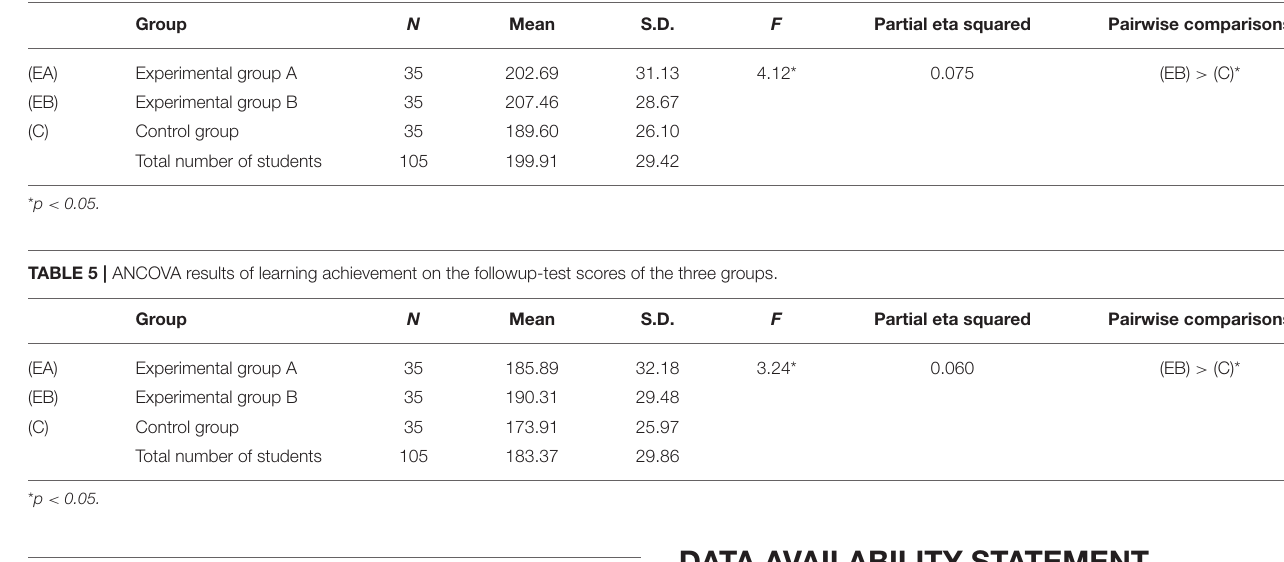
TABLE 6 | ANOVA result of cognitive load on the three groups. Group N Mean (EA) Experimental group A Experimental group B Control